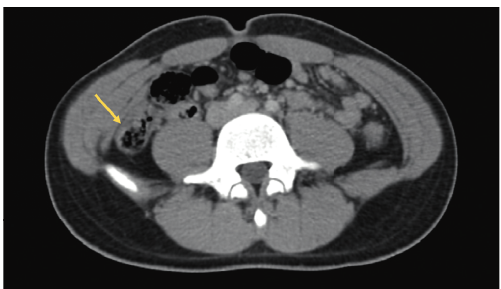
Figure 1: Computed tomography (CT) scan of the abdomen and pelvis with intravenous and oral contrast showing a thickened loop of bowel (arrow) in the right lower quadrant with ascites likely webbed into the colovesical pouch of the right paracolic gutter suggestive of